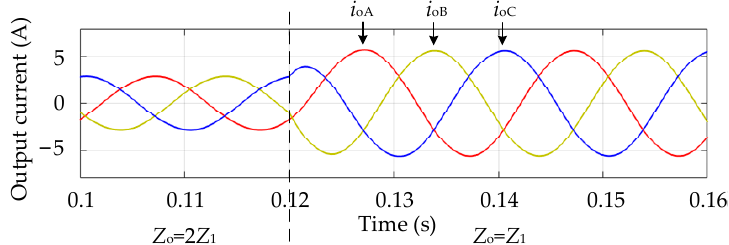
Figure 12. The output current of each phase during a resistive–inductive load transient.